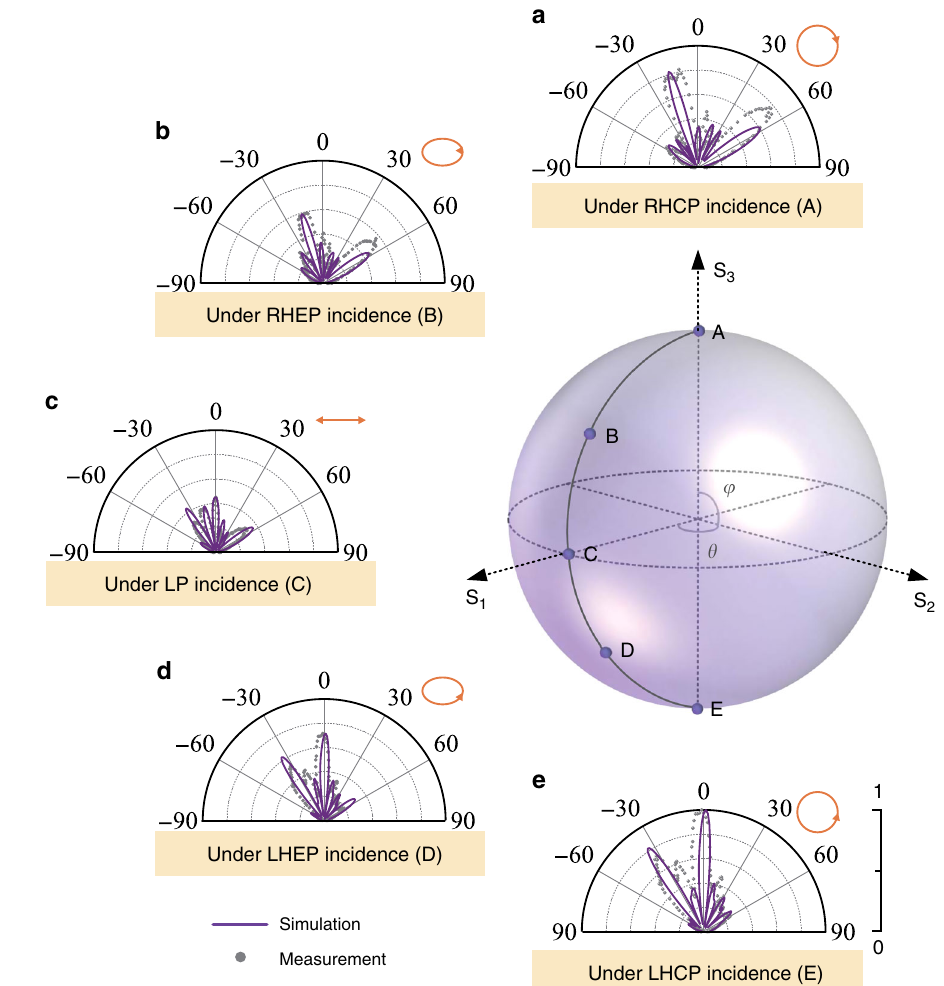
Fig. 4 Evolution of diffraction order against the variation of incident polarization state on the Poincaré sphere. a Under the RHCP incidence, two main output lobes located at − 16° and 58° carry co-polarization and cross-polarization respectively. b Under the RHEP incidence, four lobes appears at − 35°, − 16°, 0°, and 58° for L – L, R – R, L – R, and R – L channels respectively. c Under the LP incidence, four lobes are exhibited at − 35°, − 16°, 0°, and 58°. d Under the LHEP incidence, four lobes are shown at − 35°, − 16°, 0°, and 58°, which is opposite to that of RHEP incidence. e Under the LHCP incidence, only two main output lobes located at − 35° and 0° carry co-polarization and cross-polarization,